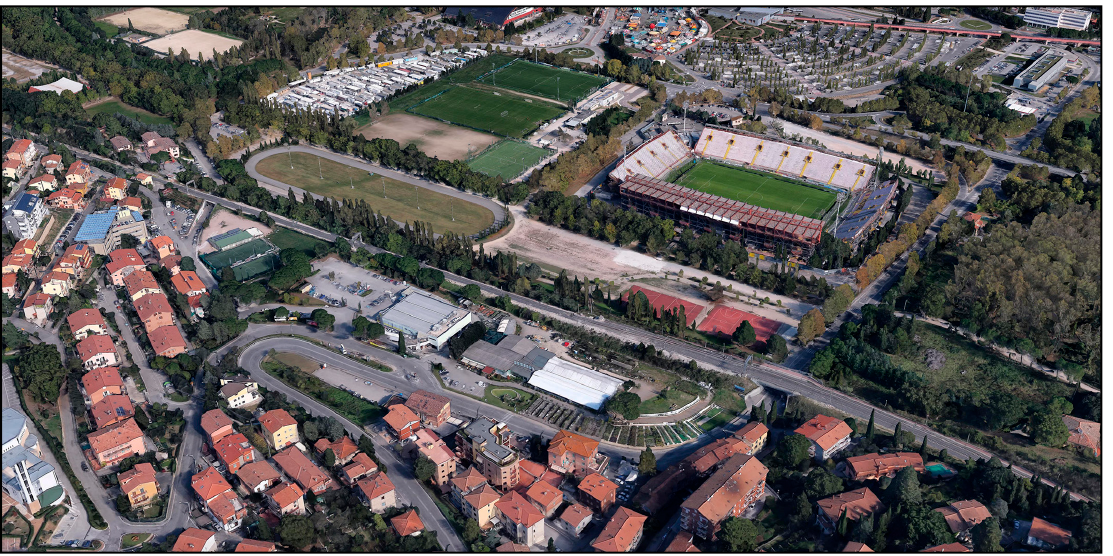
Figure 2. Perugia’s Percorso Verde_Ferro di Cavallo